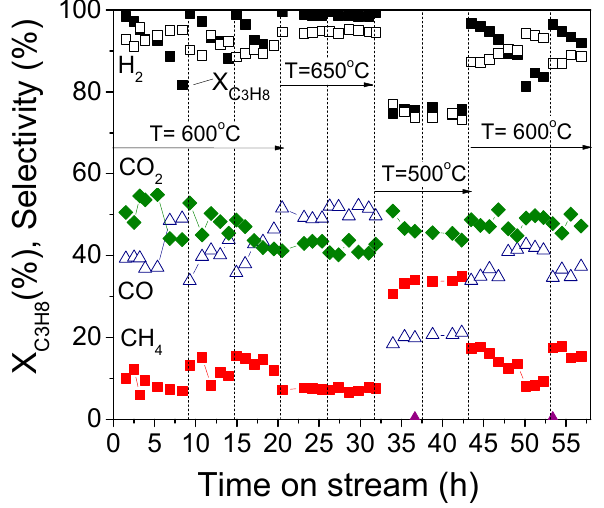
Figure 10. Long-term stability test of the 0.5%Rh/TiO 2 catalyst under conditions of C 3 H 8 steam reforming: Alterations of the conversion of C 3 H 8 and selectivities toward reaction products with time-on-stream. Experimental conditions: H 2 O/C = 3.25; GHSV= 55,900 h − 1 ; T = 500, 600, and 650 °C.